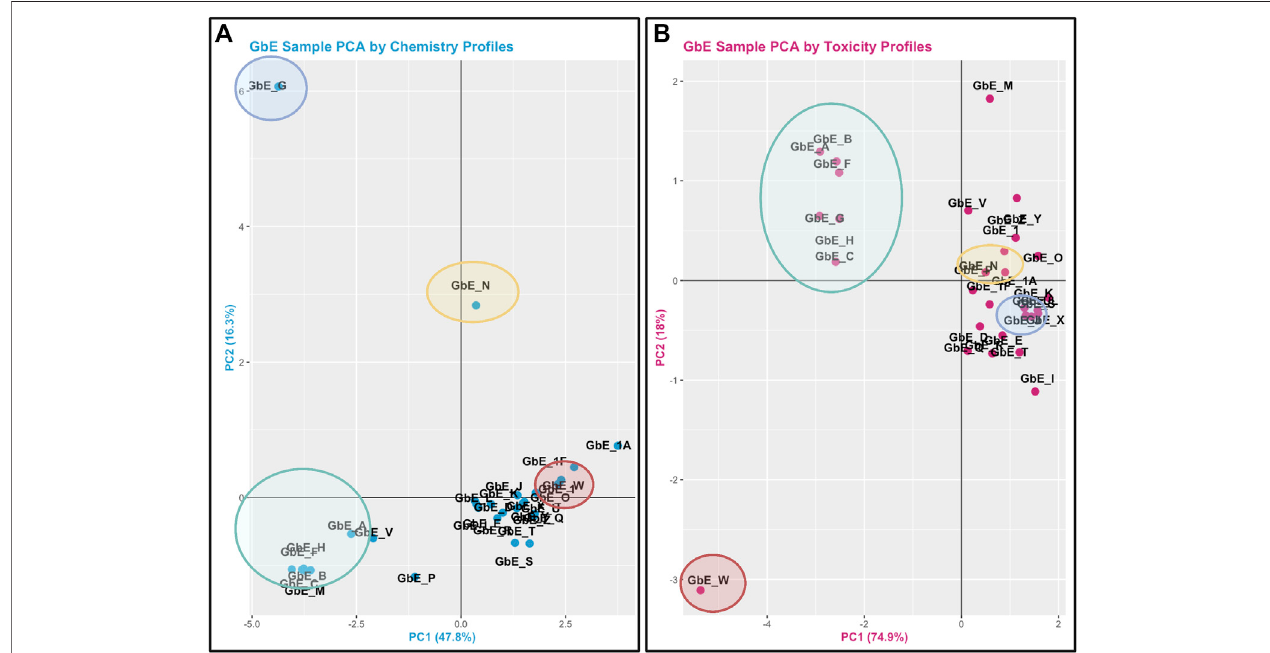
FIGURE 5 | PCA plots used to inform Ginkgo Biloba extract (GbE) groupings in mixtures-based suf fi cient similarity analyses. (A) This training module fi rst guides participants through the derivation of chemical groups within GbE produced when reviewing only chemical composition data. (B) Then, chemical groups are derived by reviewing in vitro toxicity response pro fi les associated with GbE exposures. These grouping results are then compared to highlight that important patterns may be missedwhenevaluatingjustchemistry orjusttoxicityresponsepro fi lesinamixtures-based suf fi cientsimilarityanalysis.Groupsarederivedacrossthese examples using PCA, representing a very common data reduction/visualization method used to explain the variance across high dimensional datasets.